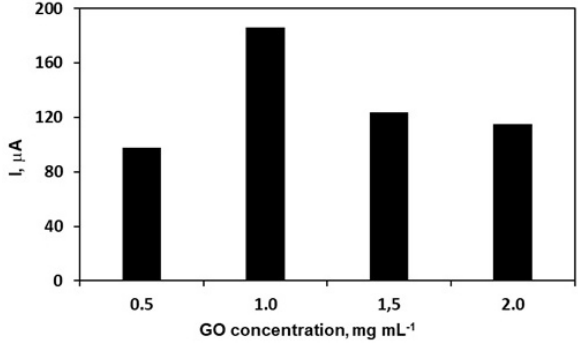
Figure 2. Effect of GO concentration on the response of the RGO/ GCE.